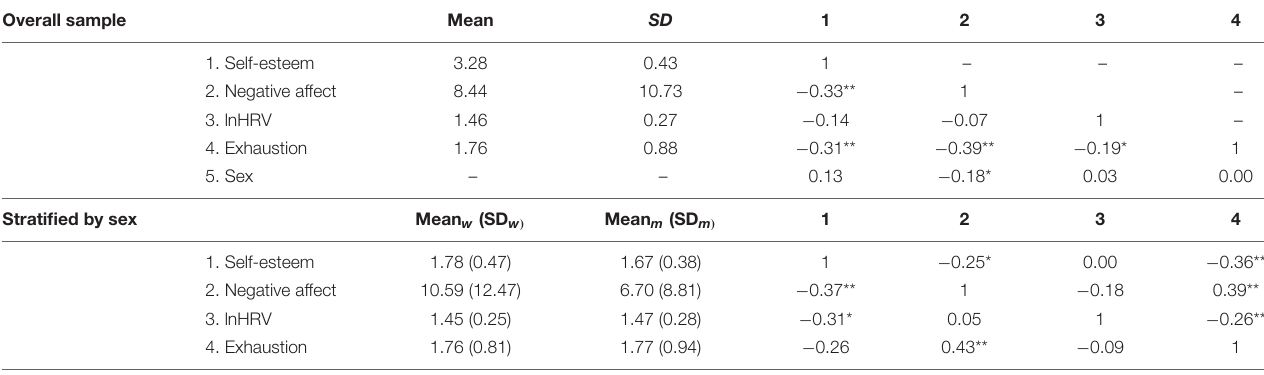
TABLE 1 | Means, standard deviations (SD), and correlations among variables. Overall